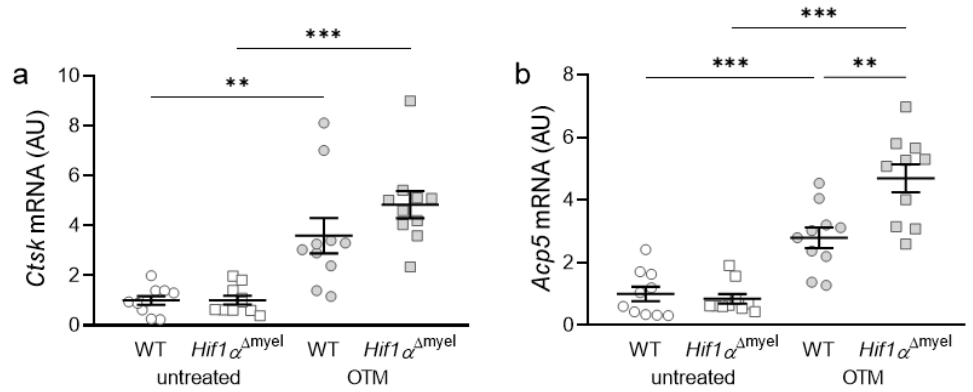
Figure 3. Gene expression of Ctsk ( a ) and Acp5 ( b ) at the orthodontically treated (OTM) and the untreated control jaw side in wildtype mice (WT) and mice without HIF1α in myeloid cells ( Hif1α Δmyel ). Statistics: Welch-corrected ANOVA with unpaired t tests. n = 10; ** p < 0.01; *** p < 0.001.